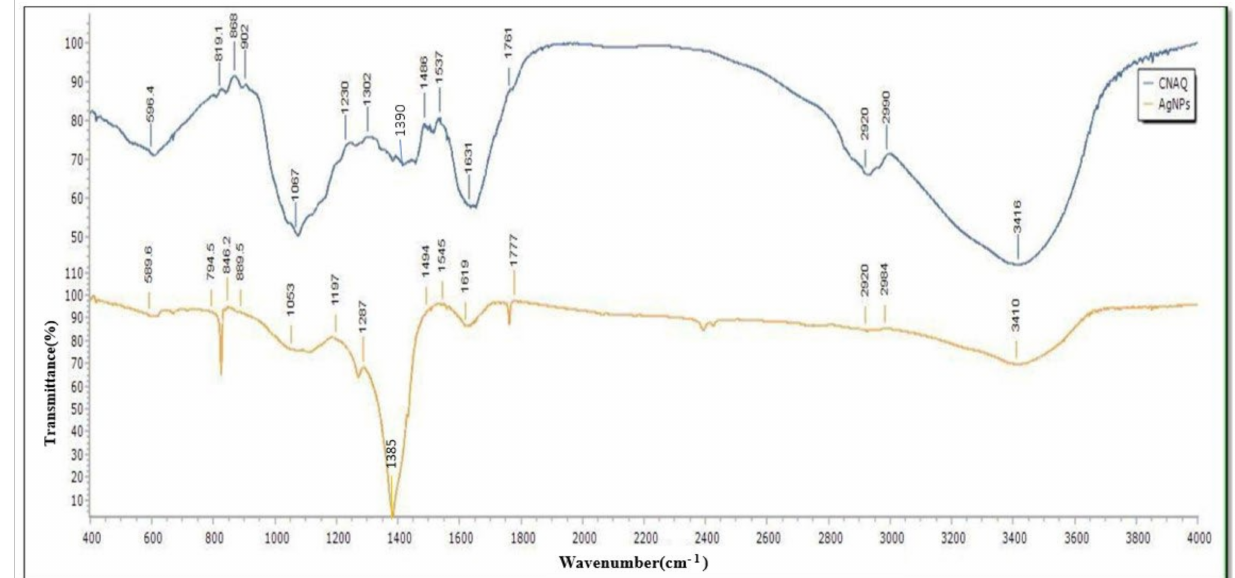
Figure 3. FTIR spectra of the CNAQ and AgNPs.